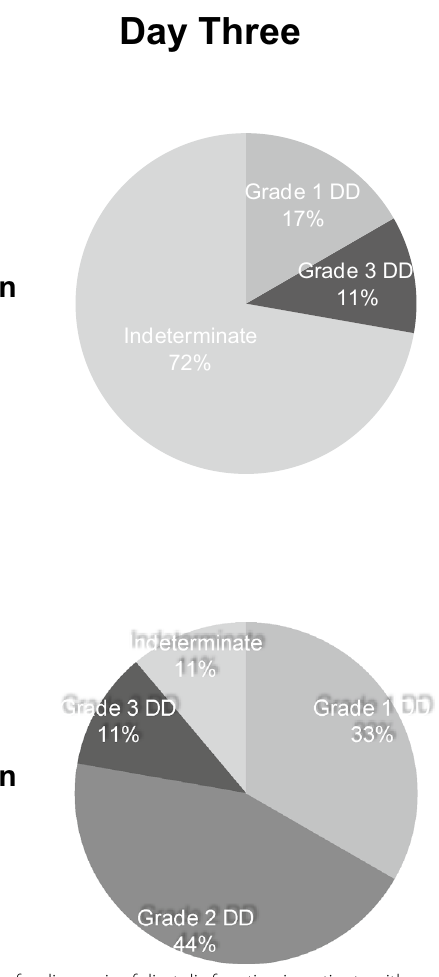
Fig. 3 Grading of diastolic dysfunction according to 2009 ASE and 2016 ASE/EACVI algorithms for diagnosis of diastolic function in patients with abnormal systolic function on day 1 and day